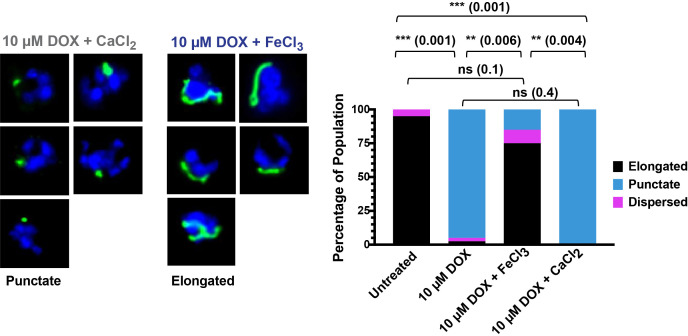
Additional epifluorescence images of D10 parasites treated with DOX and metals.Magnet plus sorbitol-synchronized parasites were treated as rings with 10 µM DOX ±500 µM FeCl3 or CaCl2 and imaged 36 hr later (green = ACPL GFP, blue = nuclear Hoechst stain). Twenty to 40 total parasites were examined for each treatment condition on each given day for duplicate experiments, and data were plotted as the average percentage of parasites in each population that displayed an elongated, punctate, or dispersed apicoplast GFP signal. For clarity, error bars are not displayed but standard errors of the mean were ≤15% in all conditions. Cell-percentage differences were analyzed by two-tailed unpaired t-test (p values in parentheses, ns = not significant).